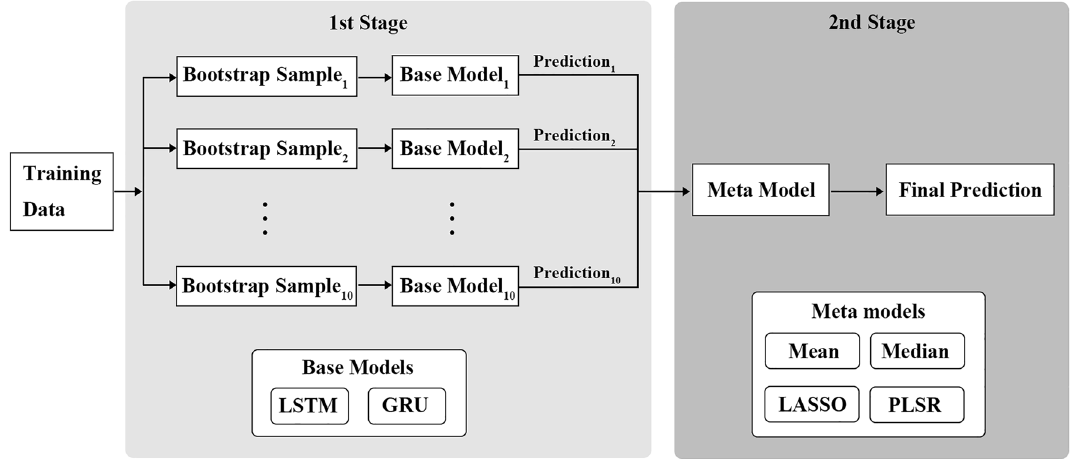
Figure 2. Structure of the ensemble